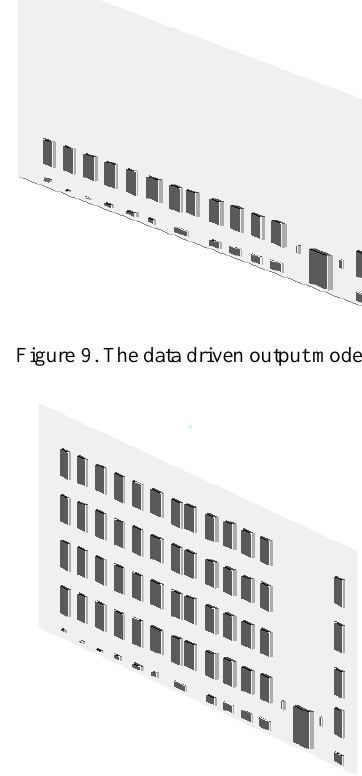
Figure 10. The grammar-based output